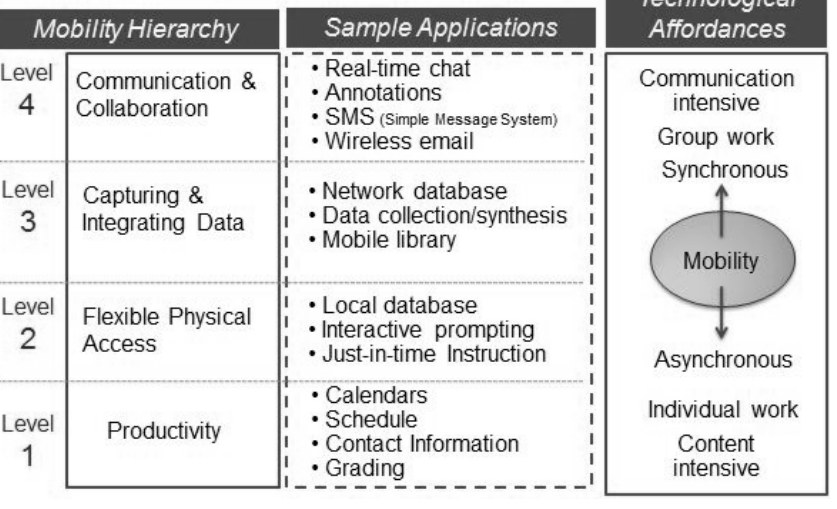
Figure 2. Mobility hierarchy, sample applications, and technological affordances. Note: Adopted from Gay, Rieger, and Bennington